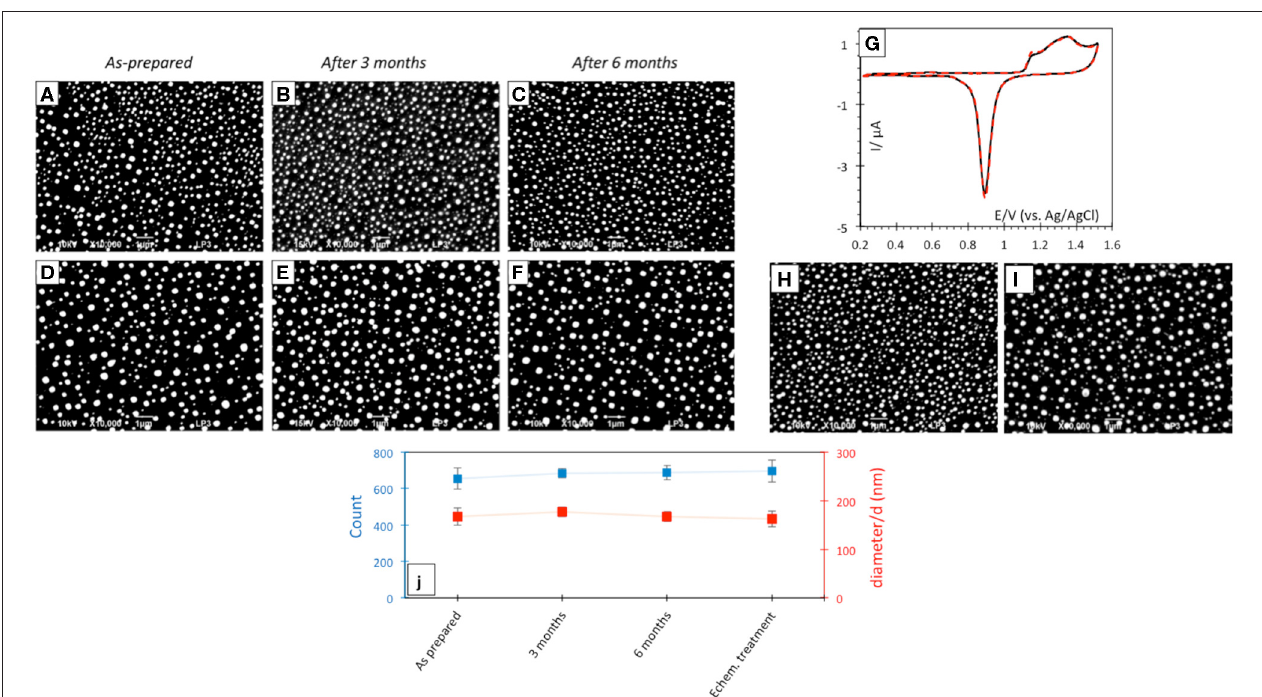
FIGURE 4 | SEM micrographs after laser treatment of 30 (A–C) and 40nm (D–F) Au film thicknesses respectively, before (A,D) and after 3 (B,E) or 6 (C,F) months storage at room temperature in air. (G) CVs in 50mM H 2 SO 4 of as prepared (black solid curve) and after 3 month storage (red dotted curve) AuNP@ITO sample from